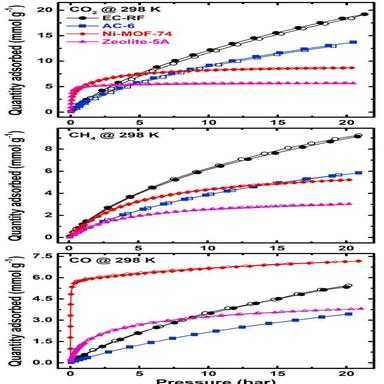
CO2, CH4, and CO adsorption (solid symbols)-desorption (open symbols) isotherms of the samples as shown measured up to 20 bar at 298 K.